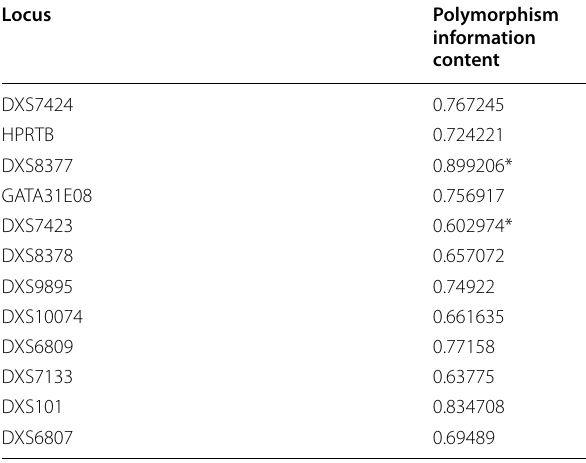
*The significance value of polymorphism information content (>